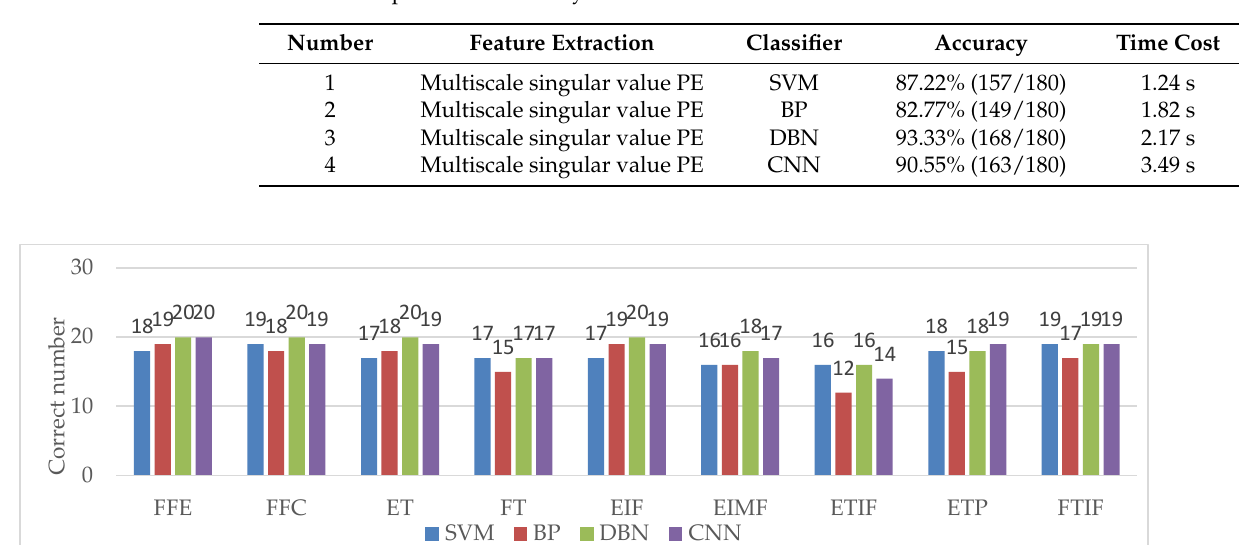
Figure 13. The correct recognition number of each gesture.